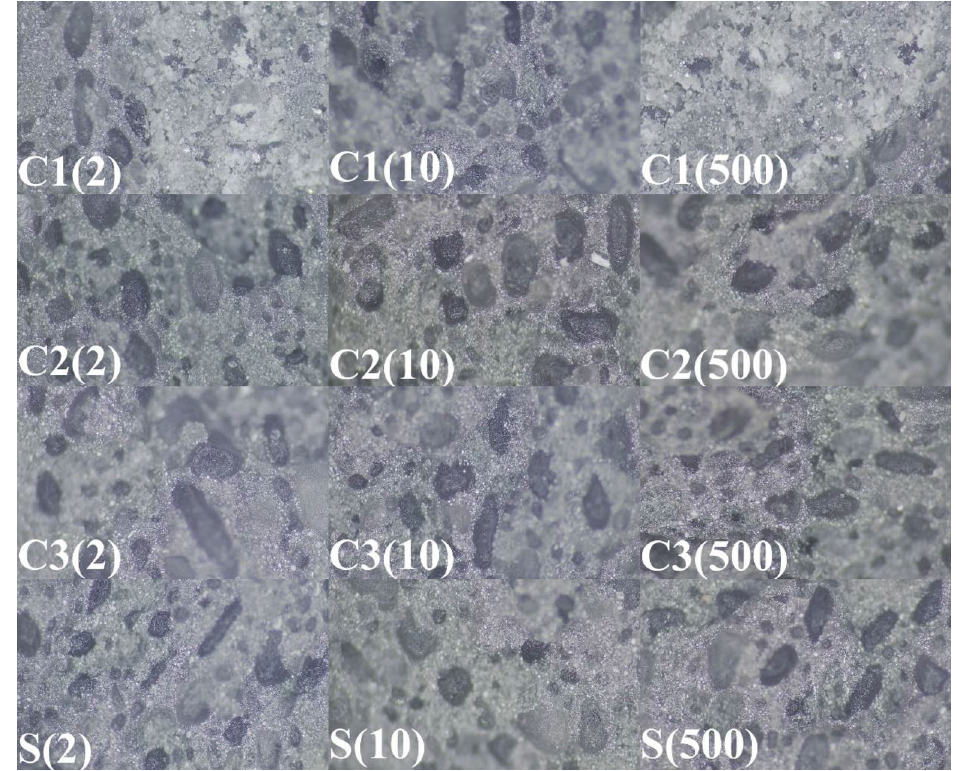
Figure 11: Specimen fracture